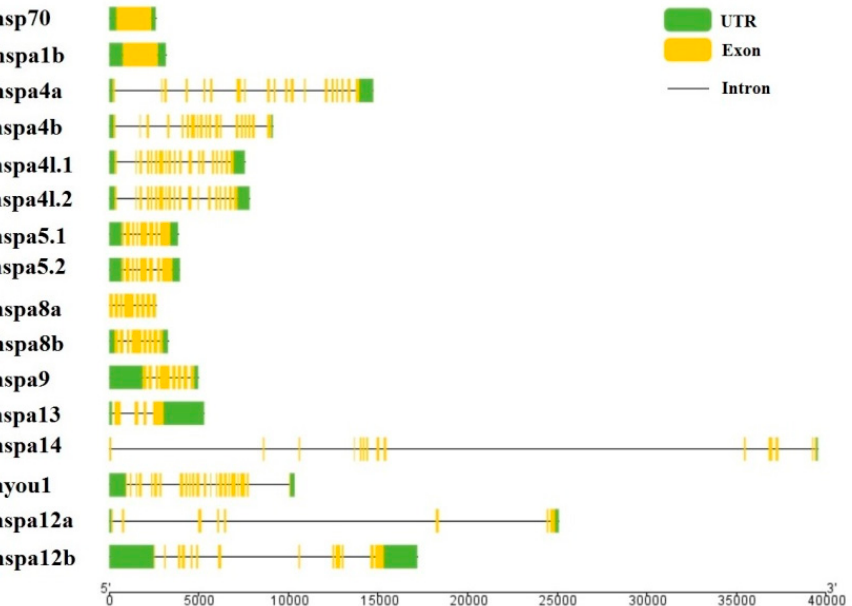
Figure 2. Exon-intron structure of large yellow croaker hsp70 genes. Green boxes indicate untranslated 5 ′ - and 3 ′ -regions; yellow boxes indicate exons; black lines indicate introns.